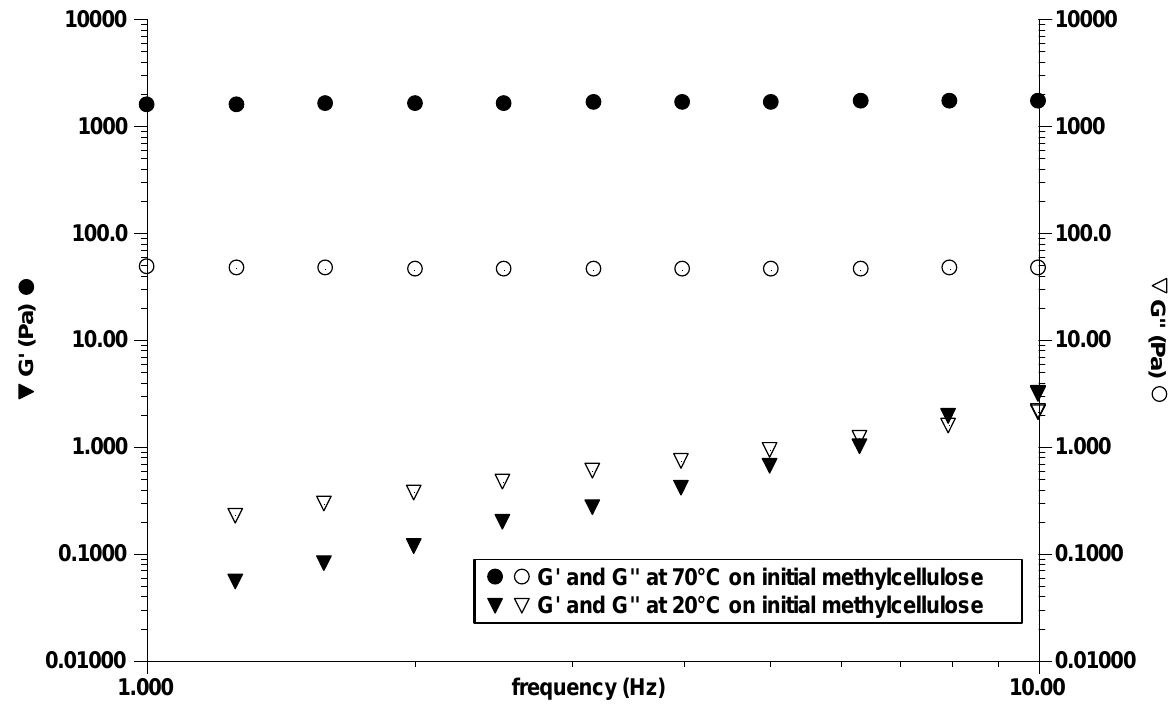
Figure 6. Dynamic moduli G’ (storage modulus, filled symbols) and G’’ (loss modulus, open symbols) (expressed in Pa) as a function of the frequency at 20 °C (solution:  and  ) and 70 °C (turbid gel:  and  ). Concentration: 30 g/L in